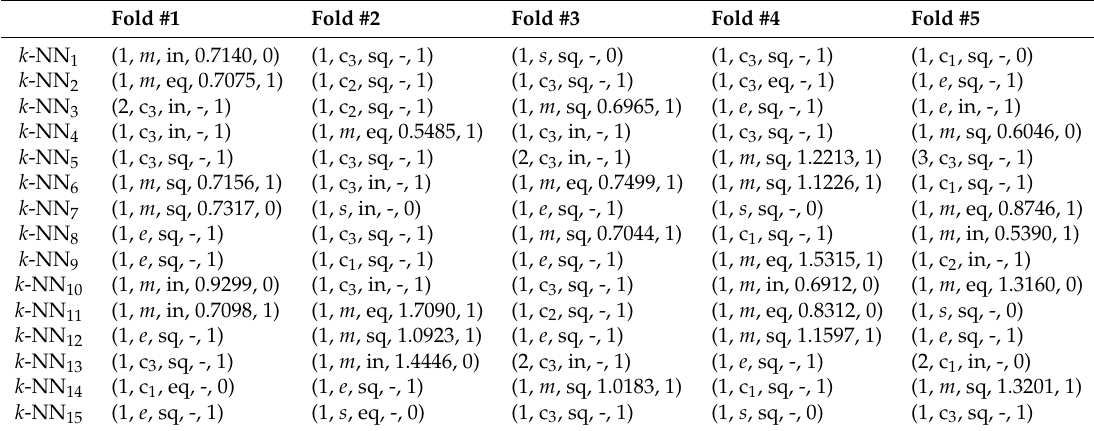
Table 4 lists the optimized parameter settings for the ensemble model consisting of 15 k -NN models in each cross-validation fold. Table 4. Parameter settings for the proposed ensemble model in five-fold cross-validation.